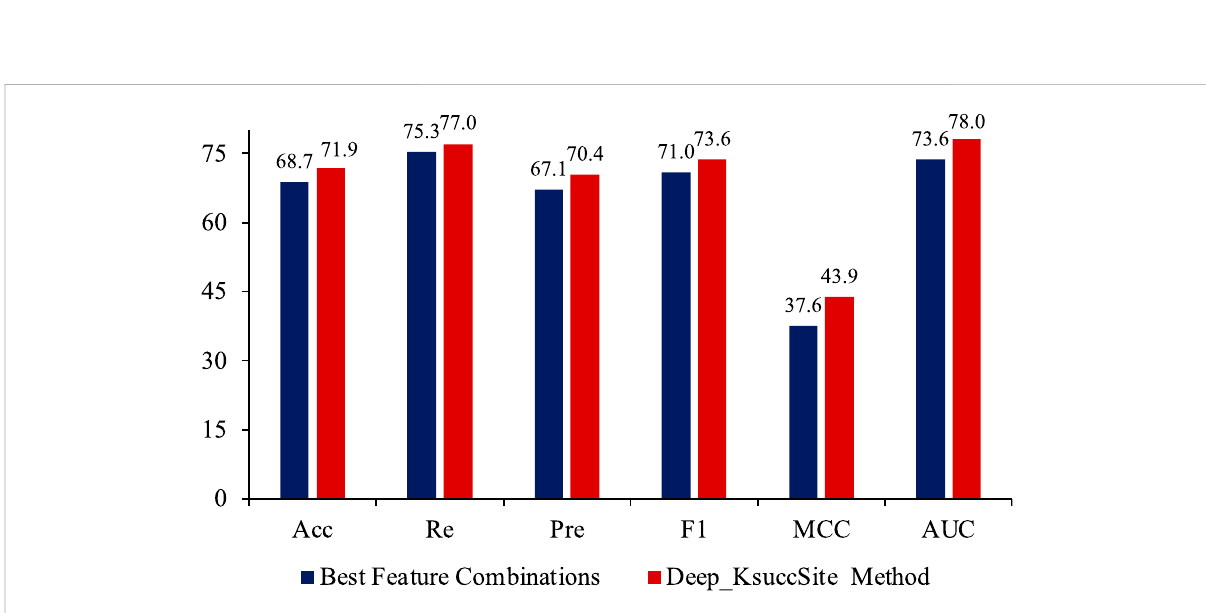
FIGURE 8 Thecomparisonofbestfeaturecombinations(EGAAC,APAACandCTDC)andDeep_KsuccSitemethodonindependenttestdata.Accordingto the results, the Deep_KsuccSite method showed consistent better performance than the best feature